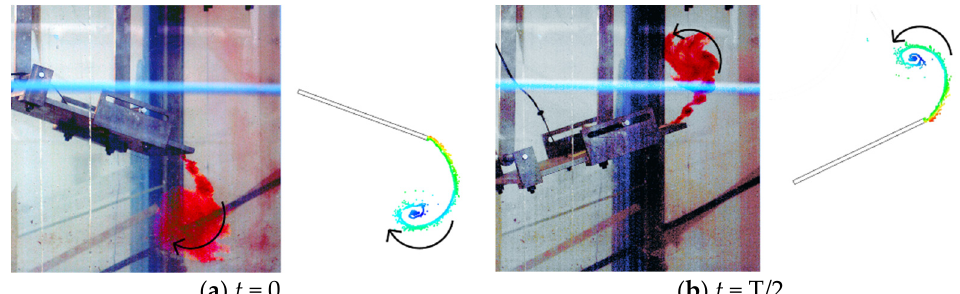
Figure 15. Comparison of flow velocity between test and simulation.